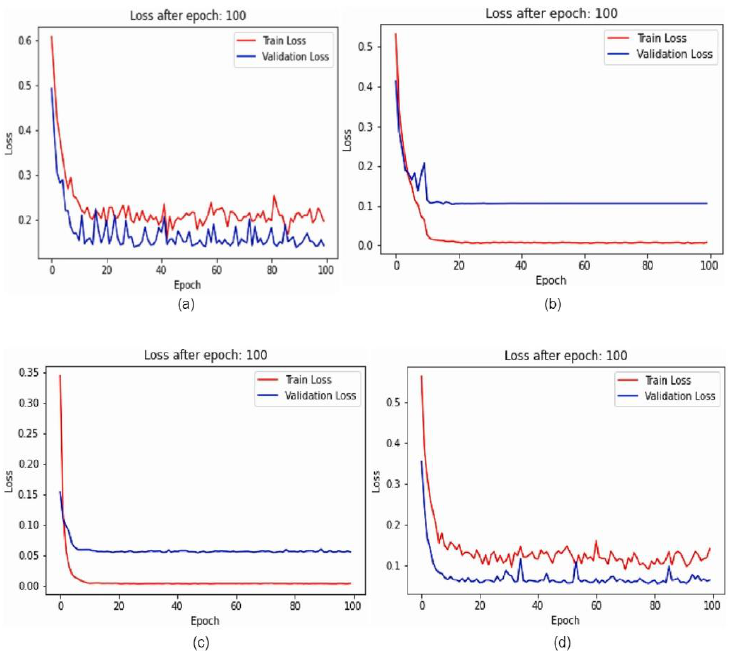
Figure 7. Loss graph for ( a ) ResNet-164, ( b ) VGG-11, ( c ) DenseNet121 and ( d ) Inception V4.